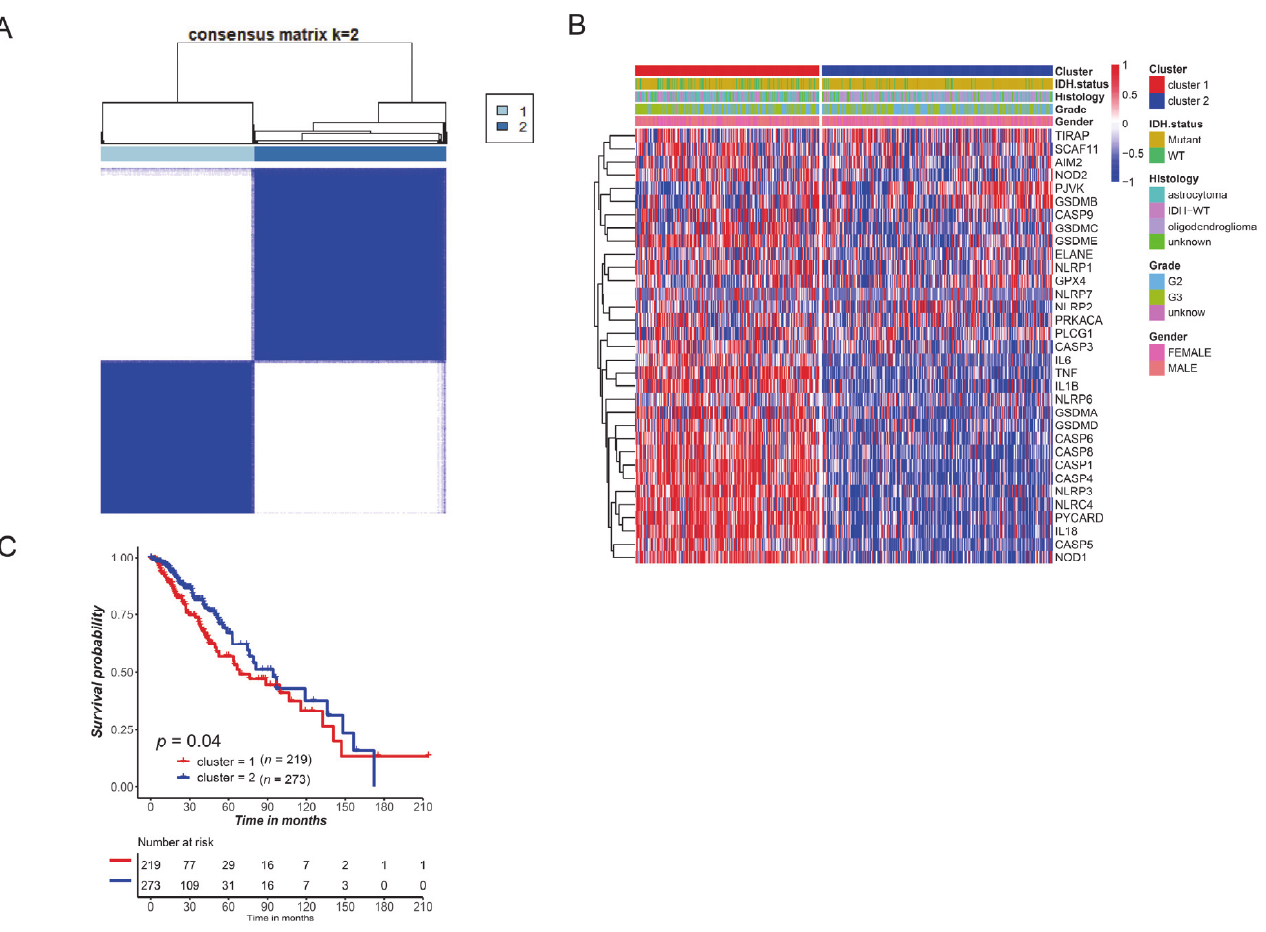
Figure 2. Identification of tumor cluster pattern. ( A ) The TCGA-LGG patients were divided into 2 cluster patterns (K = 2). ( B ) Different clinical characteristics among the 2 clusters. ( C ) Survival difference between 2